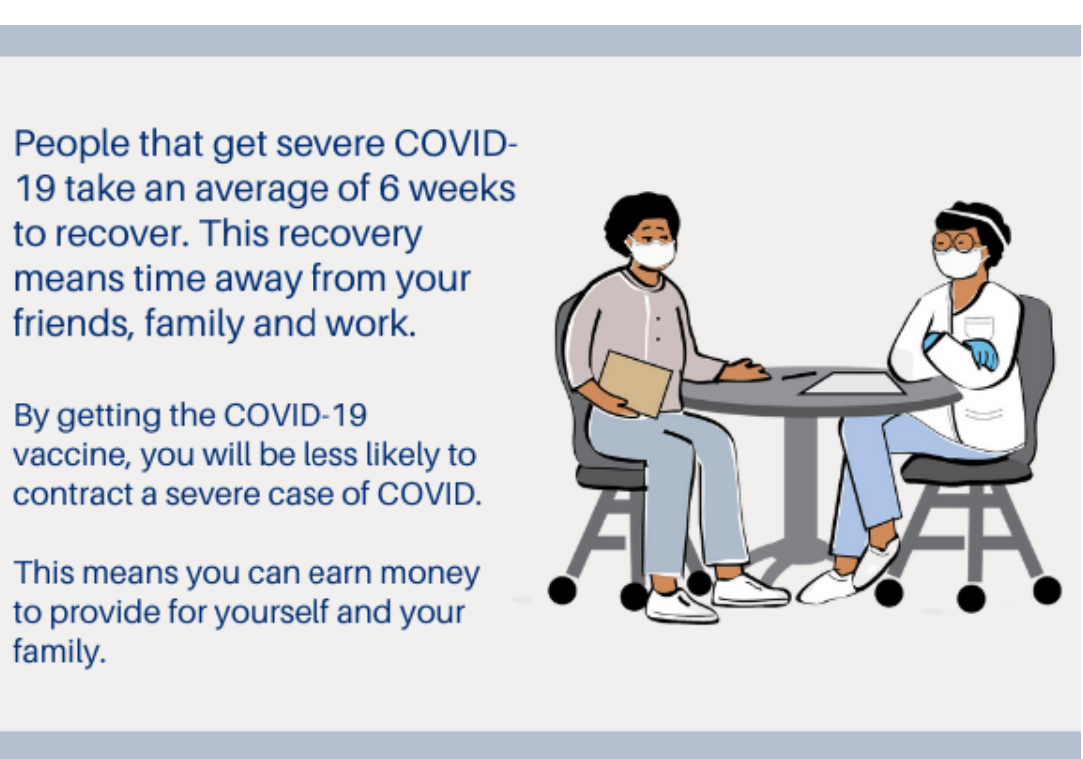
Economic - healthcare provider. Figure A2. Disease outcome peer.